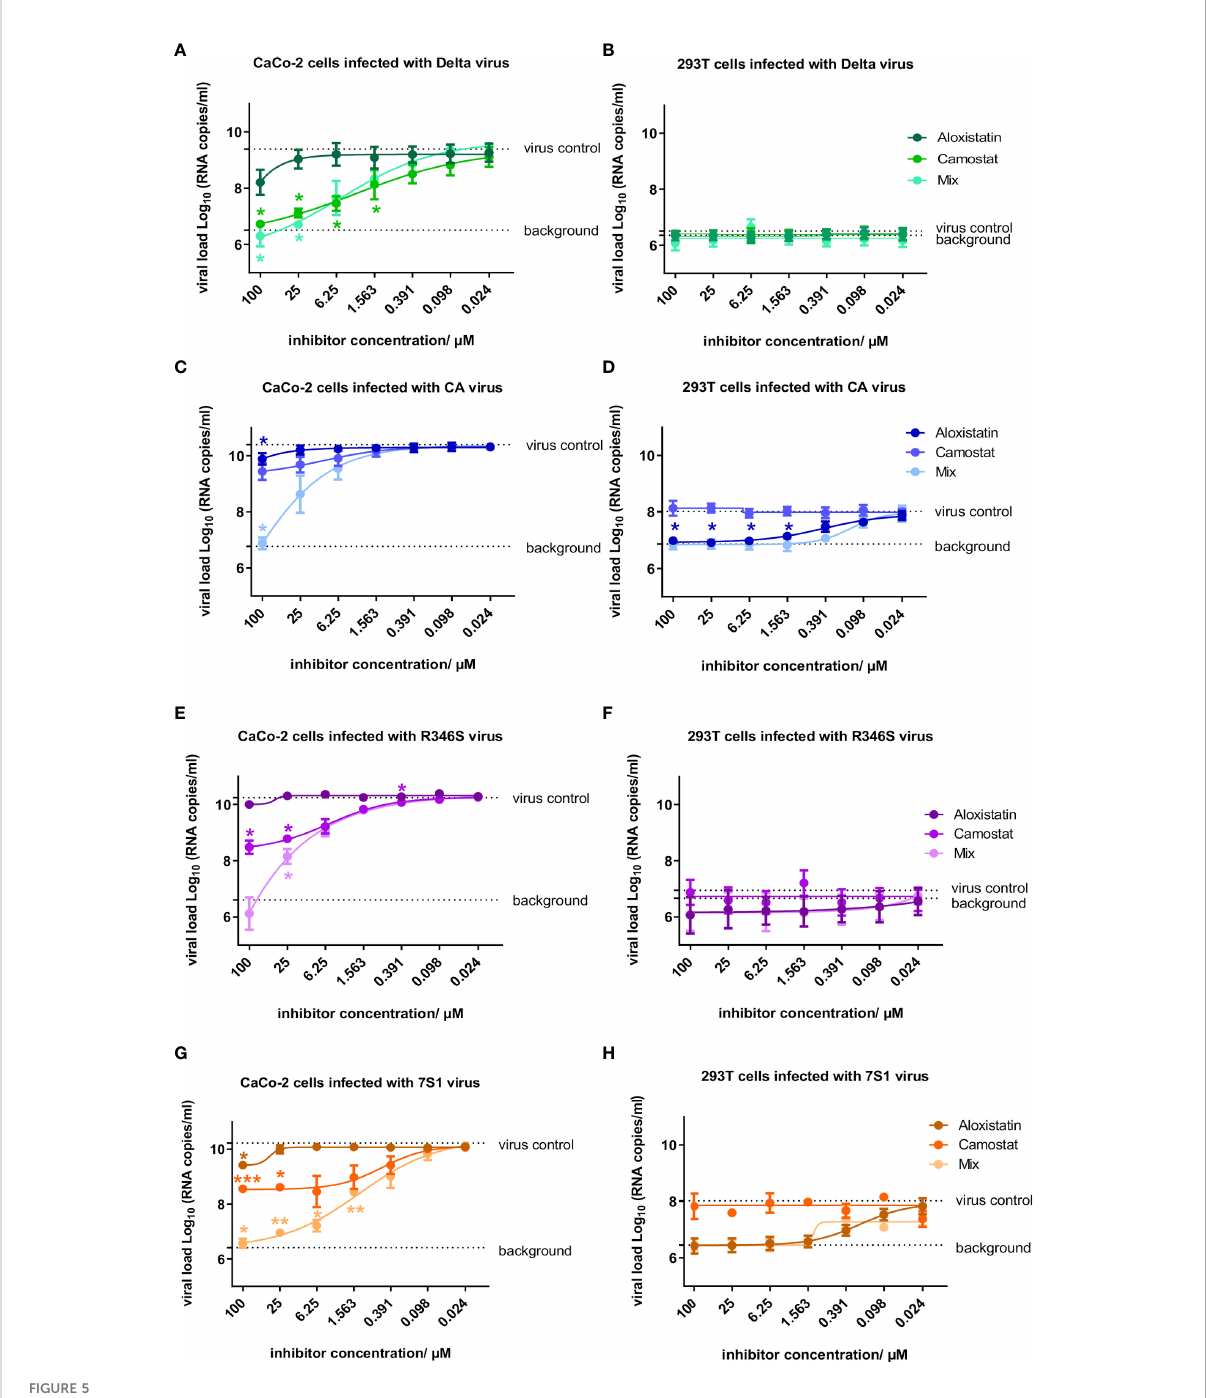
FIGURE 5 Susceptibility of SARS-CoV-2 variants to inhibition of endocytosis and fusion by aloxistatin and camostat, respectively. CaCo-2 and HEK293T cells were infected with (A, B) a SARS-CoV-2 Delta strain (39), (C, D) wild-type virus (CA) used as input for selection of S309-resistant strains, and mutant strains with (E, F) R346S and (G, H) R346S+P337L (7S1), using a multiplicity of infection of 0.05. Cells were propagated in the presence of the endocytosis inhibitor aloxistatin, the fusion inhibitor camostat or both in a 1:1 ratio (mix) at concentrations of the individual inhibitors between 0.024-100 µM. At 2d post infection, SARS-CoV-2 concentrations were determined in cell culture supernatants and plotted as log viral load in a non-linear fi t, using cells infected in the absence of inhibitors (virus control) and cells fi xed with 4% paraformaldehyde (background control) as constraints. Data show mean and standard error of three independent experiments. Statistics was calculated using one-way ANOVA with Dunnett ’ s correction, comparing each inhibitor concentration with the respective uninhibited control (*p<0.05, **p<0.01, ***p<0.001). Macromolecular electrostatics of the SARS-CoV-2 receptor-binding domain (RBD) upon evolution of amino acid exchange R346S is shown in Supplementary Figure